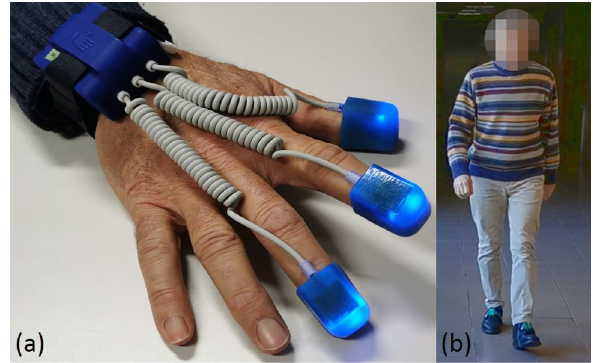
Figure 1. ( a ) SensHand system; ( b ) SensFoot